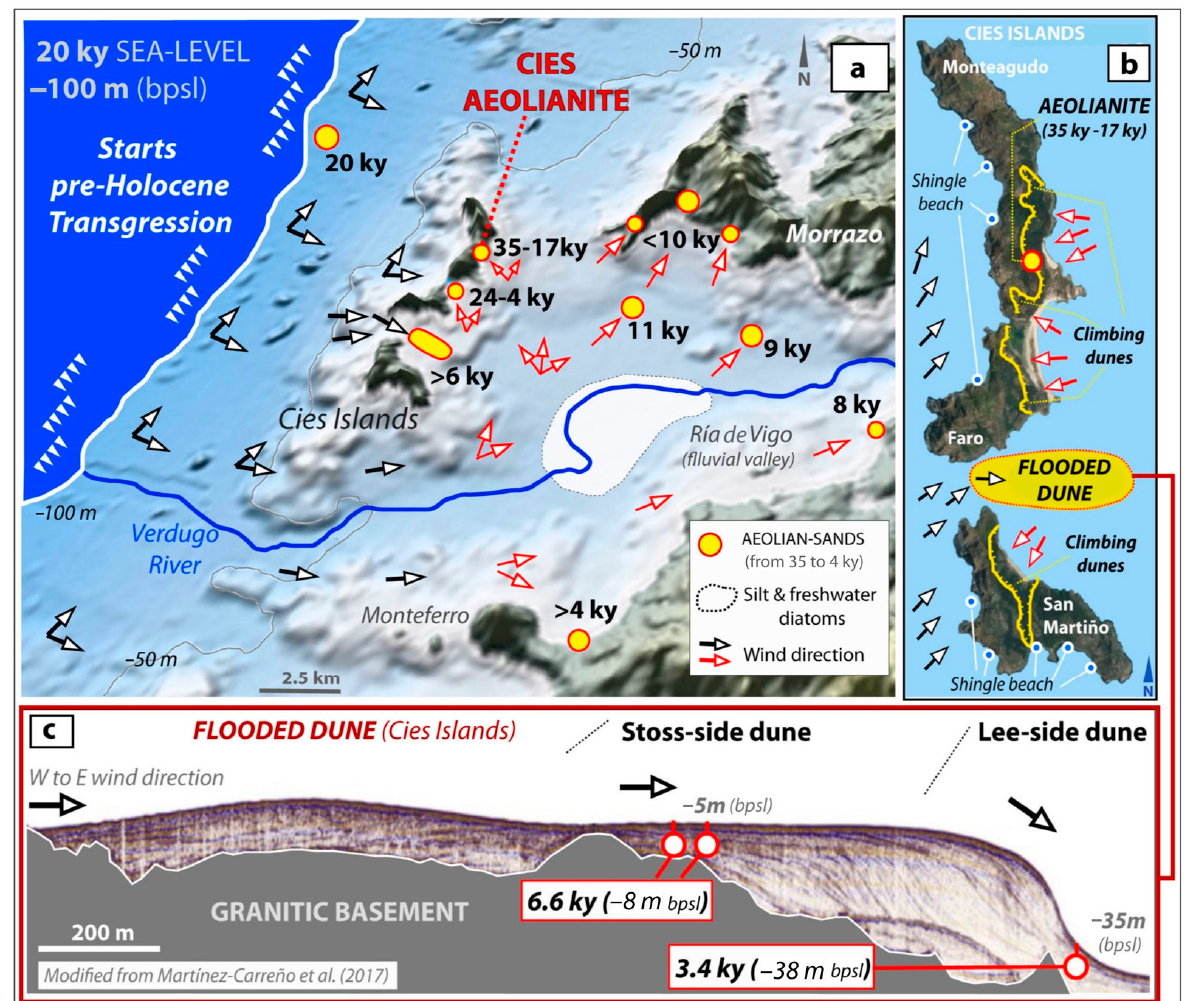
Figure 8. Aeolian sands in the Cies Islands, Ria de Vigo and continental platform. ( a ) Sea ‐ level in the study area, showing the prevailing coastal winds from SW to NE (black arrows) in the Atlantic margin of Iberian Peninsula at the end of the Last Glacial period (modified from [15]). Red arrows show local wind variations, as suggested by the aeolian sands outcrops (yellow dots). The white area represents silty sediments with freshwater diatoms [27] in the uppermost levels, most probably related to freshwater diatoms in silty sediments described in [75] between 45 to 8 ky. Relief from [26]. ( b ) Prevailing wind direction in the Cies Islands at present sea ‐ level and local variations suggests the climbing dunes advance (yellow stripes) as yet preserved in the archipelago [76]. ( c ) Flooded dune between Faro and San Martiño Islands, showing its internal structure [77] and chronology [28]. Black arrows show wind direction. (bpsl): below present sea ‐ level.